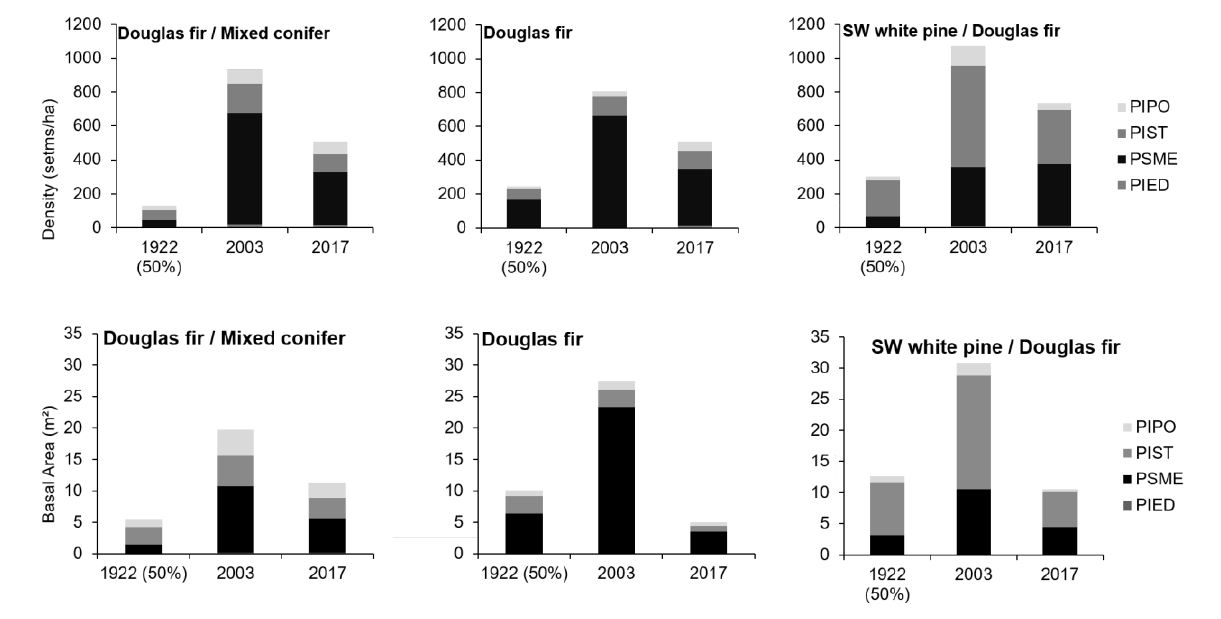
Figure 2. Tree density (top panels) and basal area (bottom panels) for plots within the PSME (Douglas fir)-mixed conifer, PSME-QUGA (Douglas fir-Gambel oak), and PIST-PSME-QUGA (Southwestern white pine-Douglas fir-Gambel oak) vegetation types. Values for 1922 are reconstructed based on tree age data and using the 50th percentile decay rate. Values for 2003 and 2017 are pre- and post-fire data collected directly from plots.